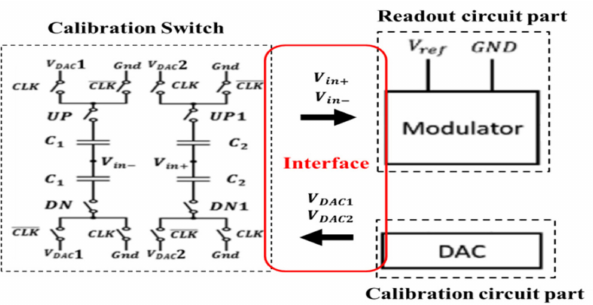
Figure 12. Calibration switches and interface of the readout and calibration circuit. The UP/DN are the switches in left side; The UP1/DN1 are the switches in right